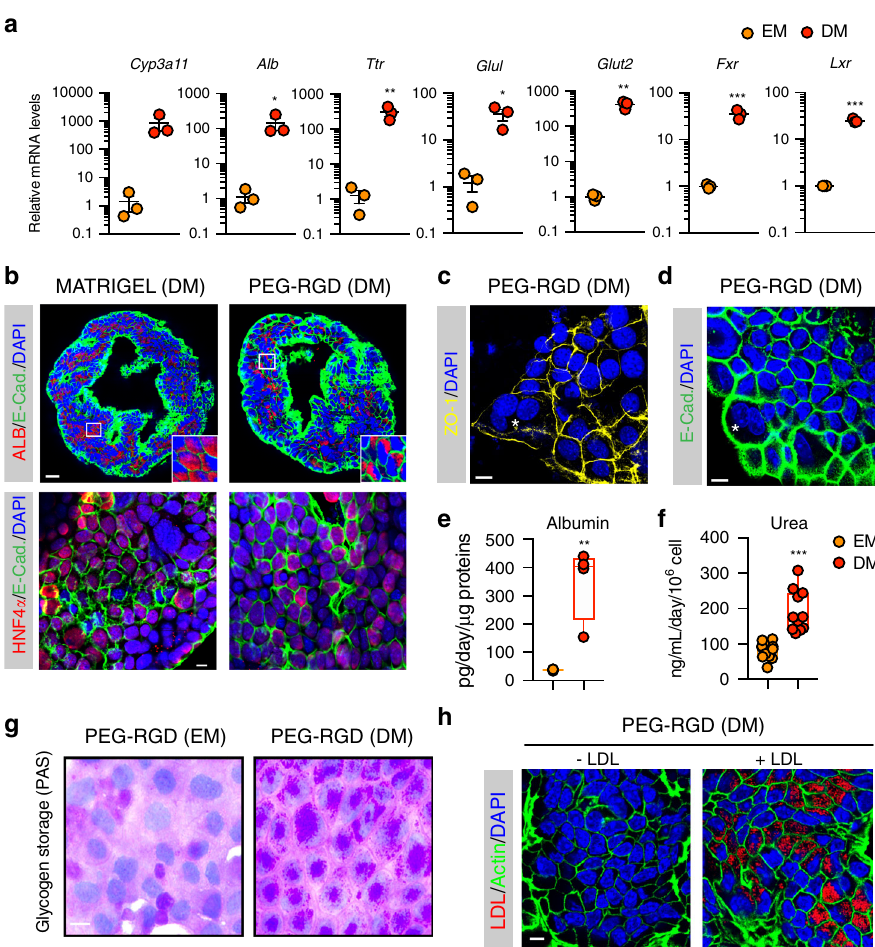
Fig. 2 Differentiation of liver organoids into hepatocyte-like cells in PEG-RGD hydrogels. a Gene expression was analysed by qRT-PCR in liver organoids maintained in expansion medium (EM) or differentiation medium (DM) in PEG-RGD hydrogels. Graphs show individual data points derived from n = 3 independent experiments and means ± SEM, unpaired Student ’ s one-tailed t -test. * P < 0.05, ** P < 0.01, *** P < 0.001 ( P = 0.030; 0.0077; 0.0007; 0.0126; 0.0009; 0.00003). b Representative confocal immuno fl uorescence images of Albumin (ALB), Hnf4a and E-Cadherin (E-CAD.). Scale bars: 25 μ m (top), 10 μ m (bottom). c Representative confocal immuno fl uorescence images of ZO-1 in liver organoids maintained in differentiation medium (DM) in PEG-RGD hydrogels. The asterisk indicates a binucleated cell. Scale bar 10 μ m. d Liver organoids maintained in differentiation medium (DM) in PEG-RGD hydrogels. E-cadherin was used to visualize cell borders. The asterisk indicates a binucleated cell. Scale bar 10 μ m. e Albumin secretion was quanti fi ed in the supernatant of organoids embedded in PEG-RGD hydrogels and maintained in EM or DM. Center line, median; box, interquartile range (IQR); whiskers, range (minimum to maximum). Red and orange dots, individual data points derived from n = 4, unpaired Student ’ s two-tailed t -test. ** P < 0.01 ( P = 0.0031). f Urea production was quanti fi ed in the supernatant of organoids embedded in PEG-RGD hydrogels and maintained in EM or DM. Center line, median; box, interquartile range (IQR); whiskers, range (minimum to maximum). Red and orange dots, individual data points derived from n = 11, unpaired Student ’ s two-tailed t -test. *** P < 0.001 ( P < 0.0001). g Glycogen accumulation was assessed by PAS (Periodic-Acid Schiff) staining in liver organoids embedded in PEG-RGD hydrogels and maintained in EM or DM. Scale bar 10 μ m. h LDL uptake was monitored by Dil-ac-LDL fl uorescent substrate in liver organoids maintained in DM in PEG-RGD hydrogels. Scale bar 10 μ m. Micrographs ( b – d , g , h ) are representative of three independent experiments. Source data are provided as a Source Data fi